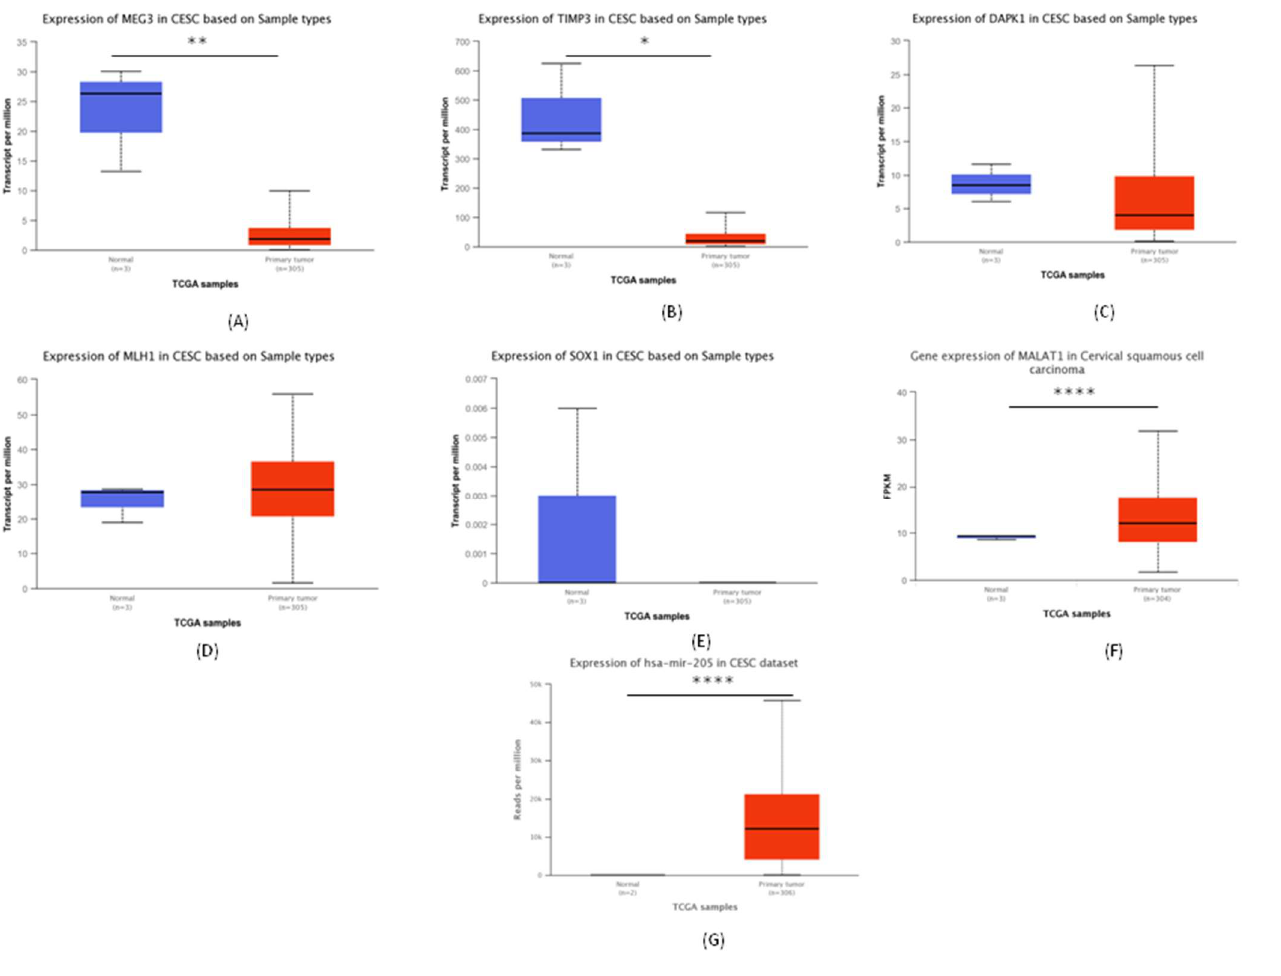
Figure 2. Expression levels of ( A ) MEG3, ( B ) TIMP3 , ( C ) DAPK1 , ( D ) MLH1 , ( E ) SOX1 , ( F ) MALAT1 and ( G ) miR-205-5p in the TCGA dataset. (* p ≤0.05, ** p ≤0.01, **** p ≤0.0001)